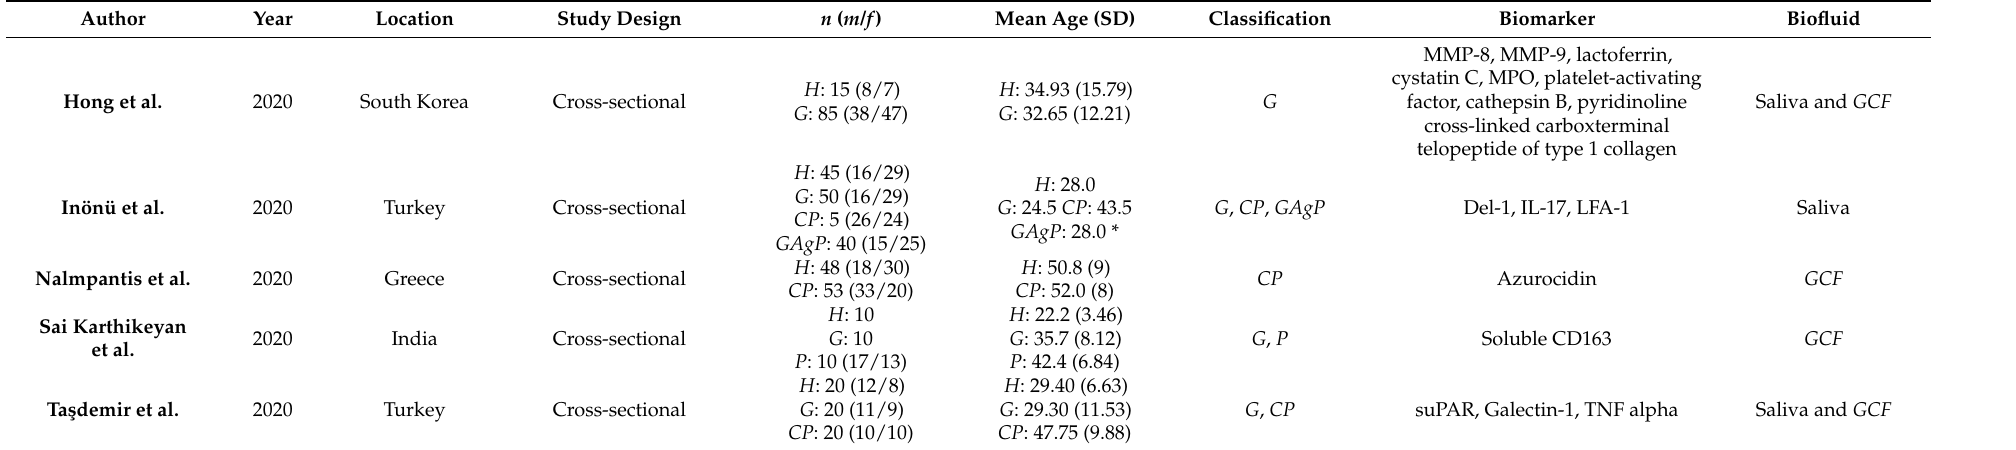
Table 5. Base-line characteristics of studies analyzing inflammatory biomarkers in oral